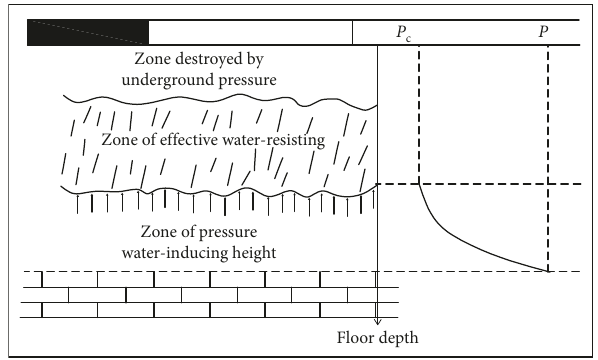
Figure 2: Schematic diagram of water pressure loss in the